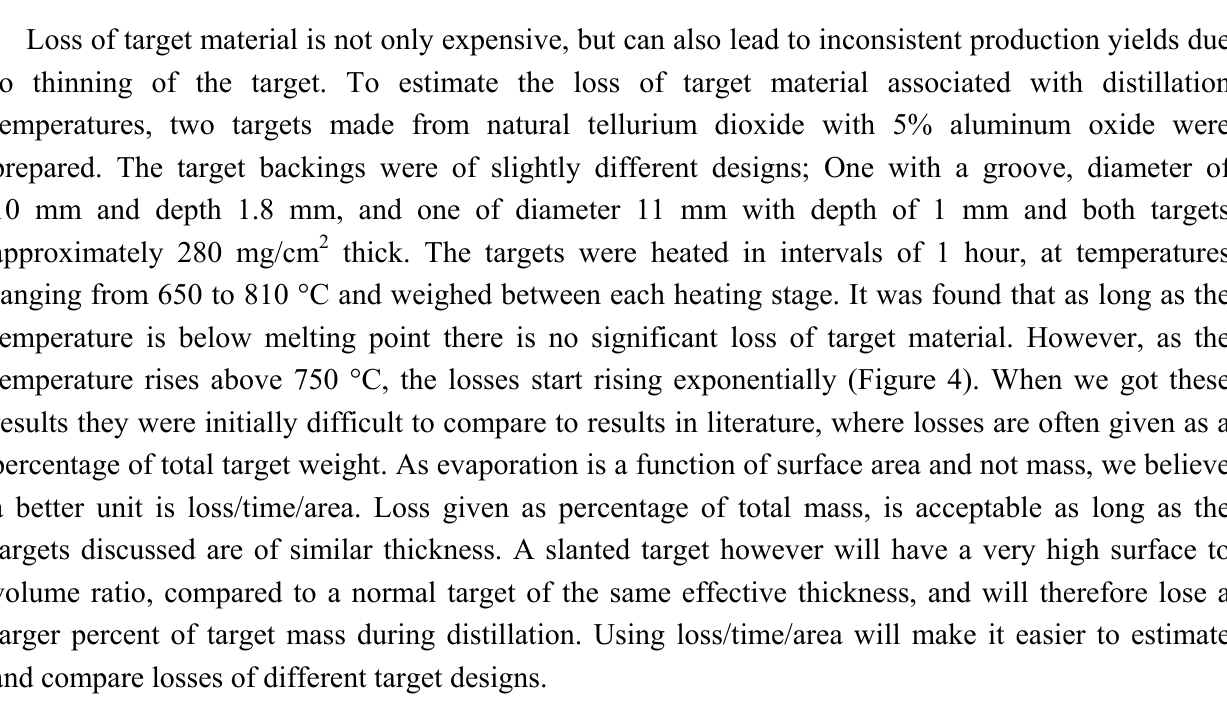
Figure 4. Graph showing the loss of target material associated with 1 h of distillation at a range of temperatures. It should be noted that these experiments were done without any air flow over the target